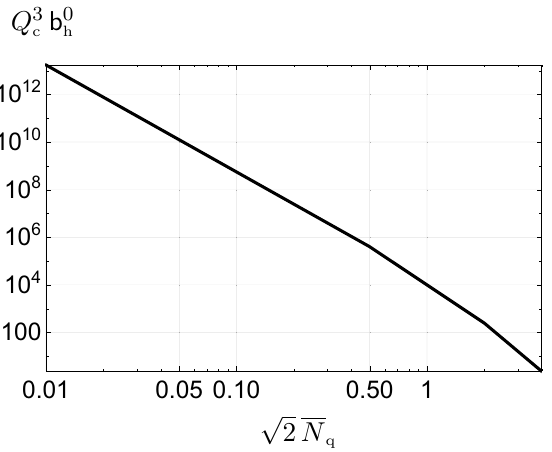
Figure 6 . Fit of the function b 0